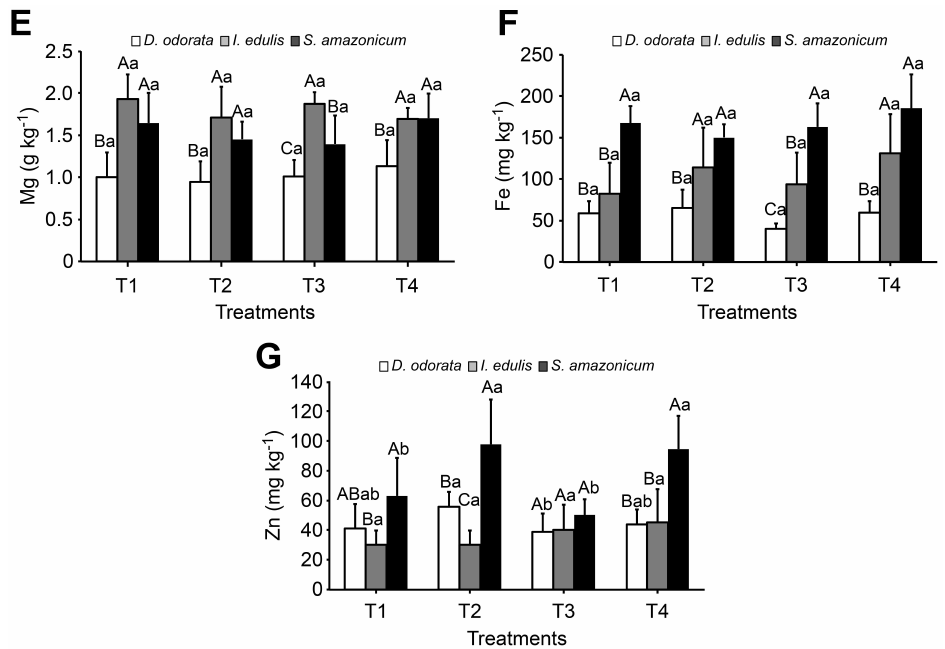
Figure 3. ( A ) Leaf nitrogen (N); ( B ) phosphorus (P); ( C ) potassium (K); ( D ) calcium (Ca); ( E ) magnesium (Mg); ( F ) iron (Fe) and ( G ) zinc (Zn) contents in all of the treatments. Mean of six samples ( ˘ SD); mean values followed by the same letters did not differ between the treatments at p ď 0.05 based on Duncan’s test. Uppercase letters compare the three species within the same fertilization treatment, and lowercase letters compare different fertilization treatments for each